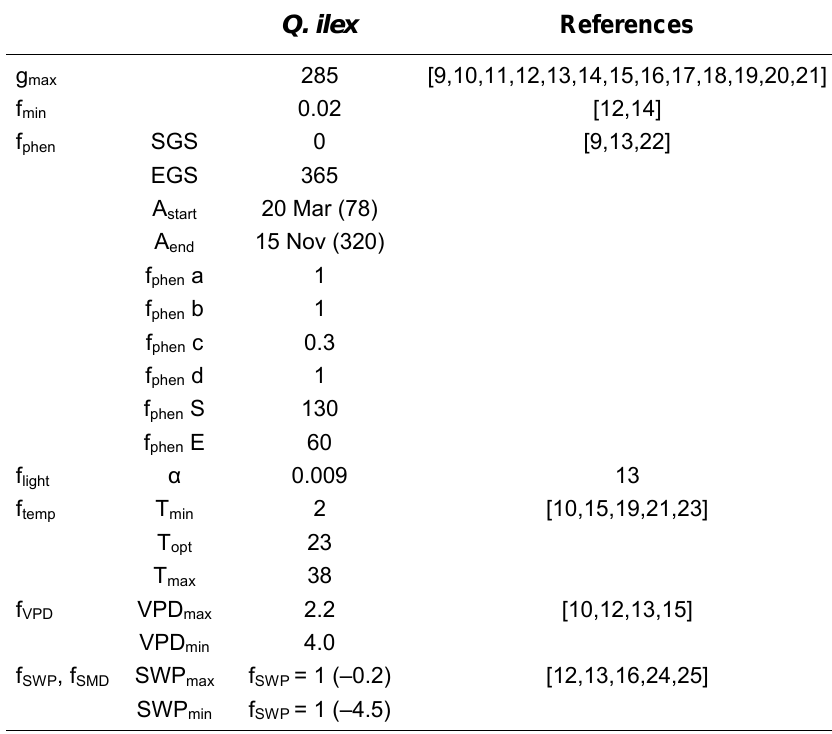
SE g Model Based on Literature 3 s